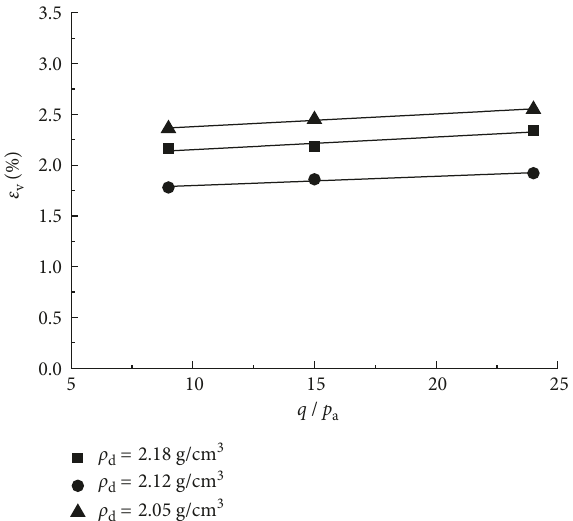
Figure 16: q / p a versus ε v curve (different mother